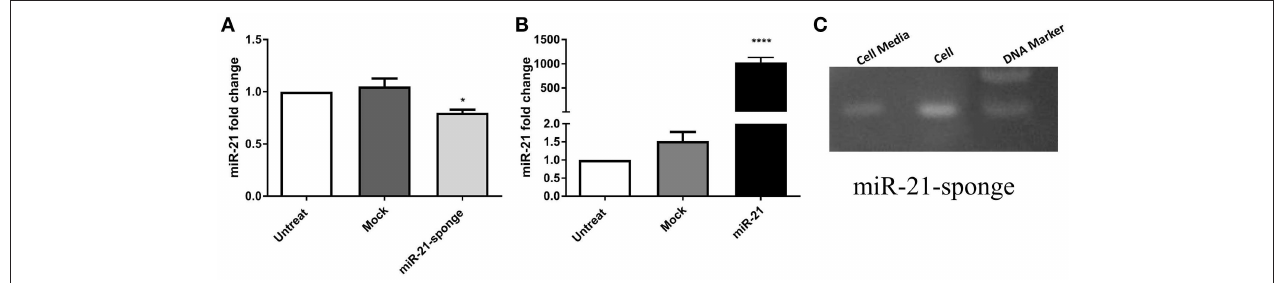
FIGURE 1 | The expression level of miR-21 in HEK-293T stable cell lines exogenously expressing pri-miR-21 or miR-21-sponge. (A) A decline in miR-21 level ( P < 0.05) in the cells stably expressing miR-21-sponge construct, in comparison to the untreated or stably expressing the mock-Tracer vector HEK-293T cells. (B) A dramatic upregulation of miR-21 ( P < 0.0001) in HEK-293T stable cells overexpressing pri-miR-21, in comparison to the untreated or HEK-293T cells stably expressing a mock-pLentiIII vector. (C) An agarose gel electrophoresis showing the presence of the miR-21-sponge (94 bp) in the cell lysates and cell media of miR-21-sponge expressing HEK-293T cells. * P < 0.05; **** P < 0.0001, which is represented by some statistical software like Graph Pad.